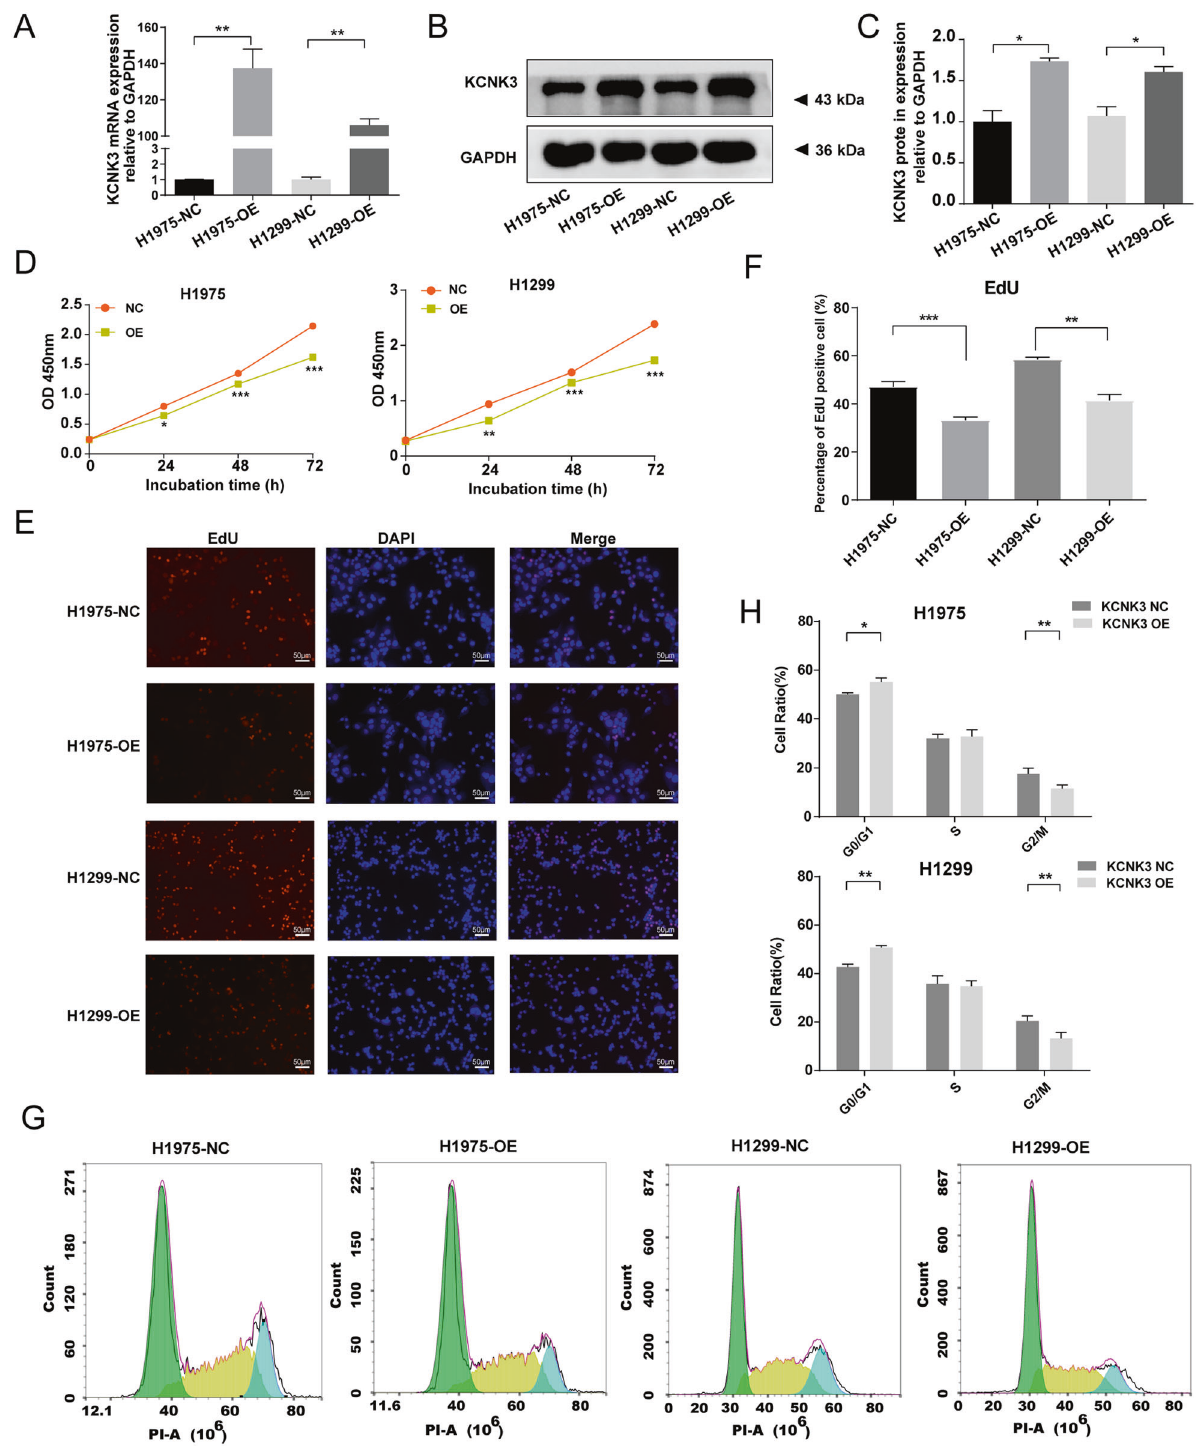
Fig. 2 Upregulation of KCNK3 expression inhibited the proliferation of LUAD cell lines. A qRT-PCR analysis of KCNK3 expression was conducted after KCNK3 overexpression lentivirus transfection in H1975 cells and H1299 cells. B , C Relative KCNK3 protein expression was measured by western blot after transfection of KCNK3 overexpression lentivirus in H1975 cells and H1299 cells, with results normalized relative to the expression of GAPDH. D The effect of KCNK3 on LUAD cell viabilities was detected by CCK-8 assay and expressed as OD values. E , F EdU-594 staining assay was performed to evaluate the proliferation of KCNK3-overexpressed LUAD cells. The positive ratio was quanti fi ed by the counts of EdU-positive cells (red) and total counts of DAPI cells (blue), scale bar 50 µm. G , H The cell cycle of KCNK3 overexpression LUAD cells was analyzed using fl ow cytometry. (NC, negative control; OE, overexpression. Data are presented as the mean ± SD of three independent experiments. (* P < 0.05, ** P < 0.01, *** P < 0.001).